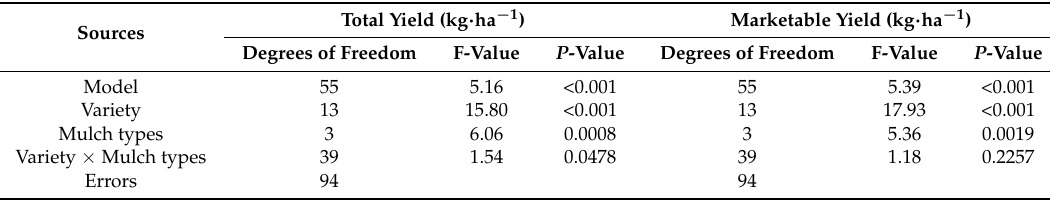
Table 1. ANOVA table partitioning the sources of variance for total and marketable sweetpotato yields (kg · ha − 1